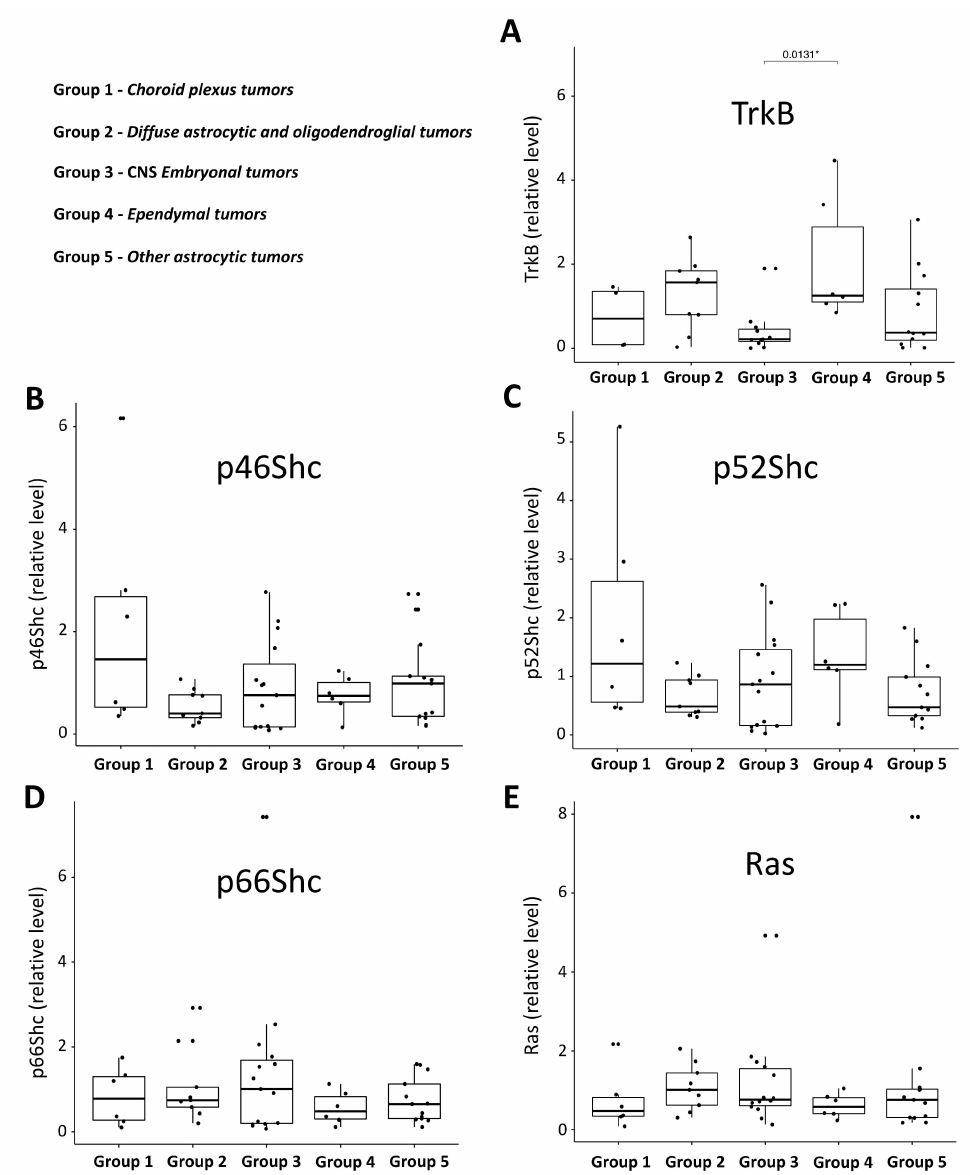
Figure 8. Box plot graphs showing the TrkB, Ras, and ShcA isoforms’ western blot quantification in investigated pediatric brain tumors. The presented box plots show the standardized levels of TrkB ( A ), p66Shc ( D ), p52Shc ( C ), p46Shc ( B ), and Ras ( E ) proteins in the five groups of tumor samples divided based on the histochemical analysis presented in Figures 1–5 and summarized in Supplementary Tables S1 and S2. The position of each dot on the vertical axis indicates values for an individual data point. * p < 0.05. The level of TrkB, p66Shc, p52Shc, p46Shc, and Ras was assessed by described in the Materials and Methods